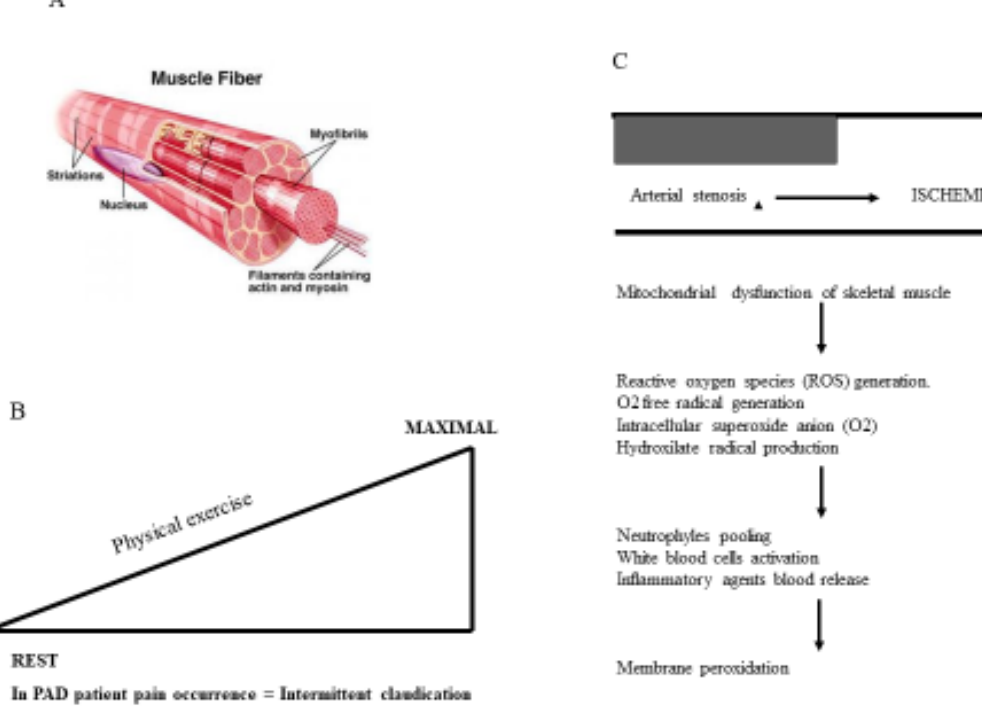
Figure 1. ( A ) Skeletal muscle contraction. ( B ) E ff ects of physical exercise (PE) in peripheral arterial disease (PAD). Maximal PE induces the intermittent claudication (i.e., characteristic symptom in PAD). ( C ) Mitochondrial, cell and membrane dysfunctions induced by arterial stenosis in a PAD